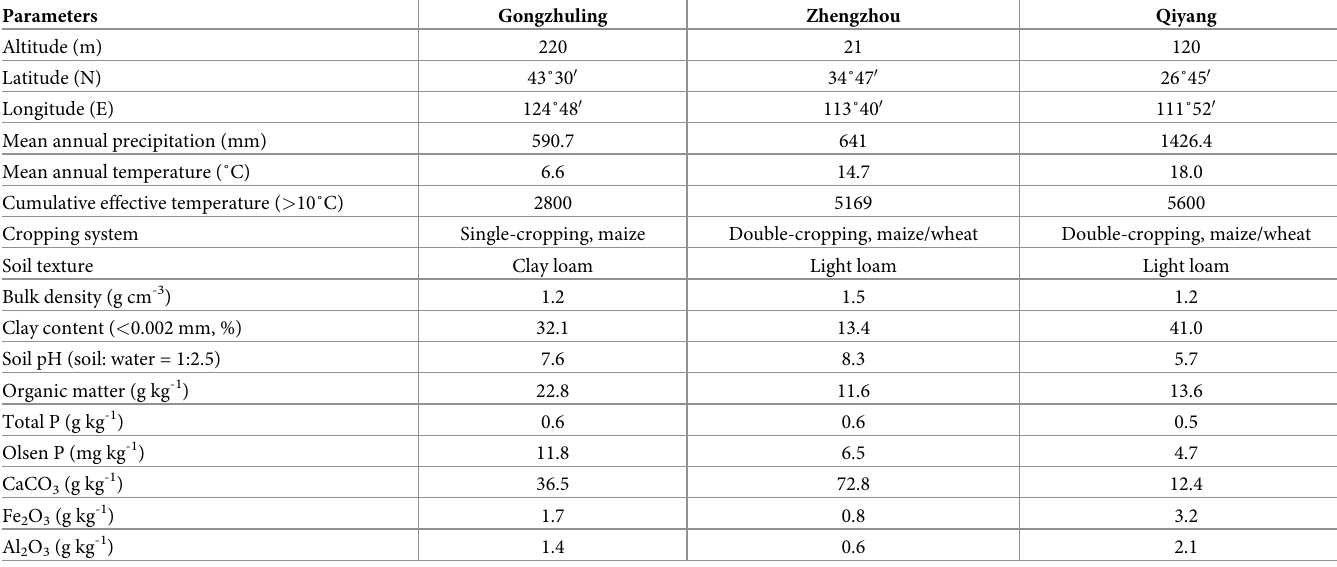
Table 1. Locations, climate conditions (shown as the mean for 1990–2012, as obtained from the China meteorological sharing service system (http://cdc.cma.gov. cn/)), and the initial surficial soil properties (1990) of the three